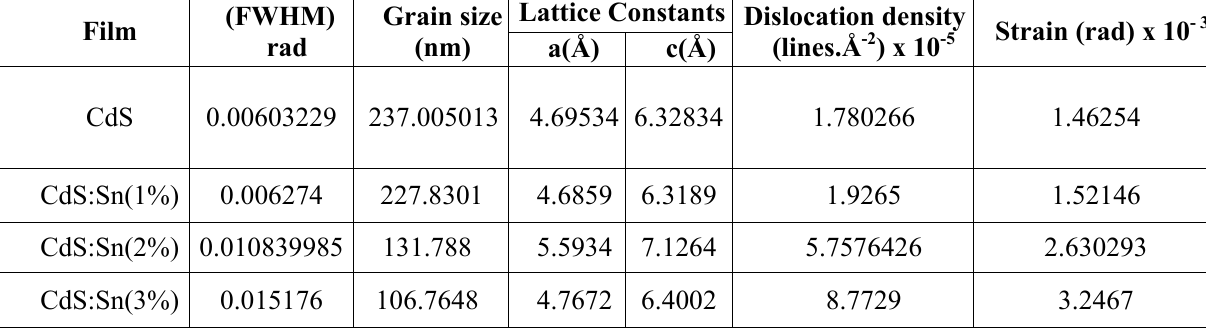
Table 2: Variation of the full width at half maximum, grain size, lattice constants, dislocation density and strain of CdS and CdS:Sn thin